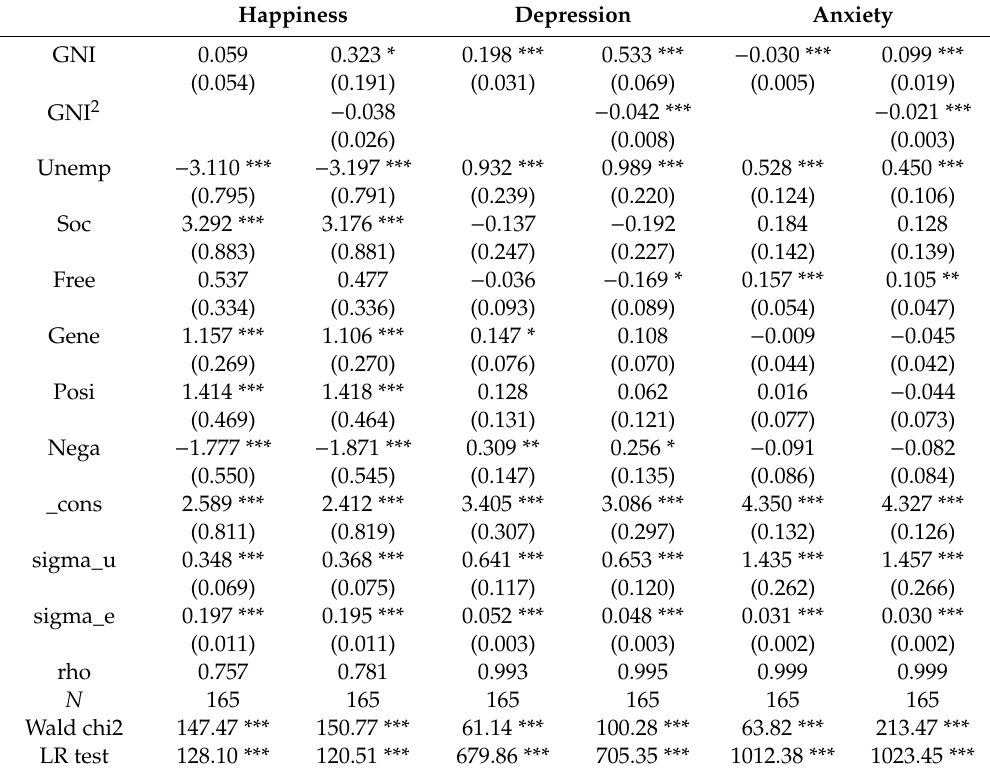
Table 5. The impact of national income on mental health among high-income countries. Happiness Depression Anxiety GNI